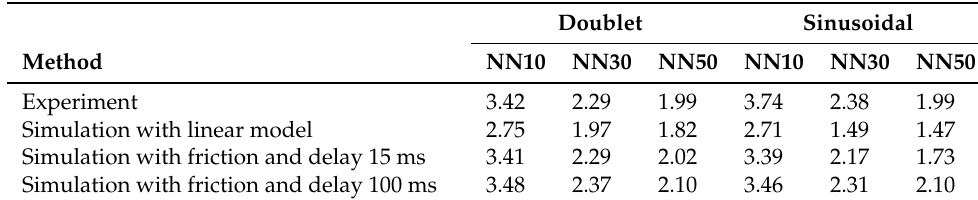
( b ) With sinusoidal command. Figure 11. Root-Mean-Square Error (RMSE) distributions over wind speeds. RMSE was calculated for the angle of attack. Experimental results as well as theoretical simulation results using different models were plotted. NN10, NN30 and NN50 were used to follow doublet and sinusoidal commands. Table 2. Mean RMSE over wind speeds for NN10, NN30, and NN50 with doublet and sinusoidal